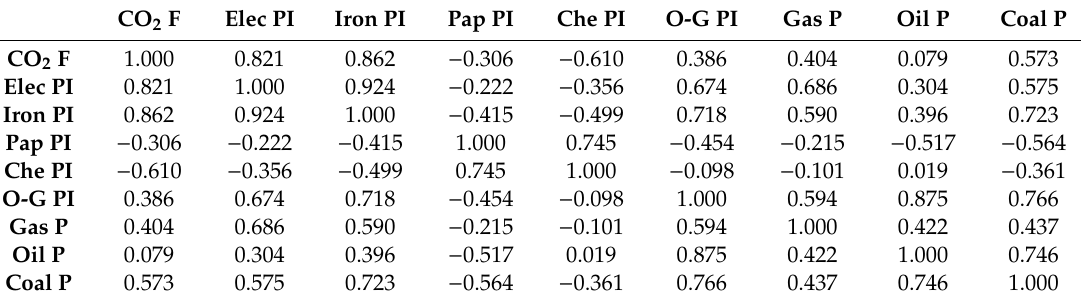
Table 2. Matrix of the correlation coe ffi cients of the analyzed